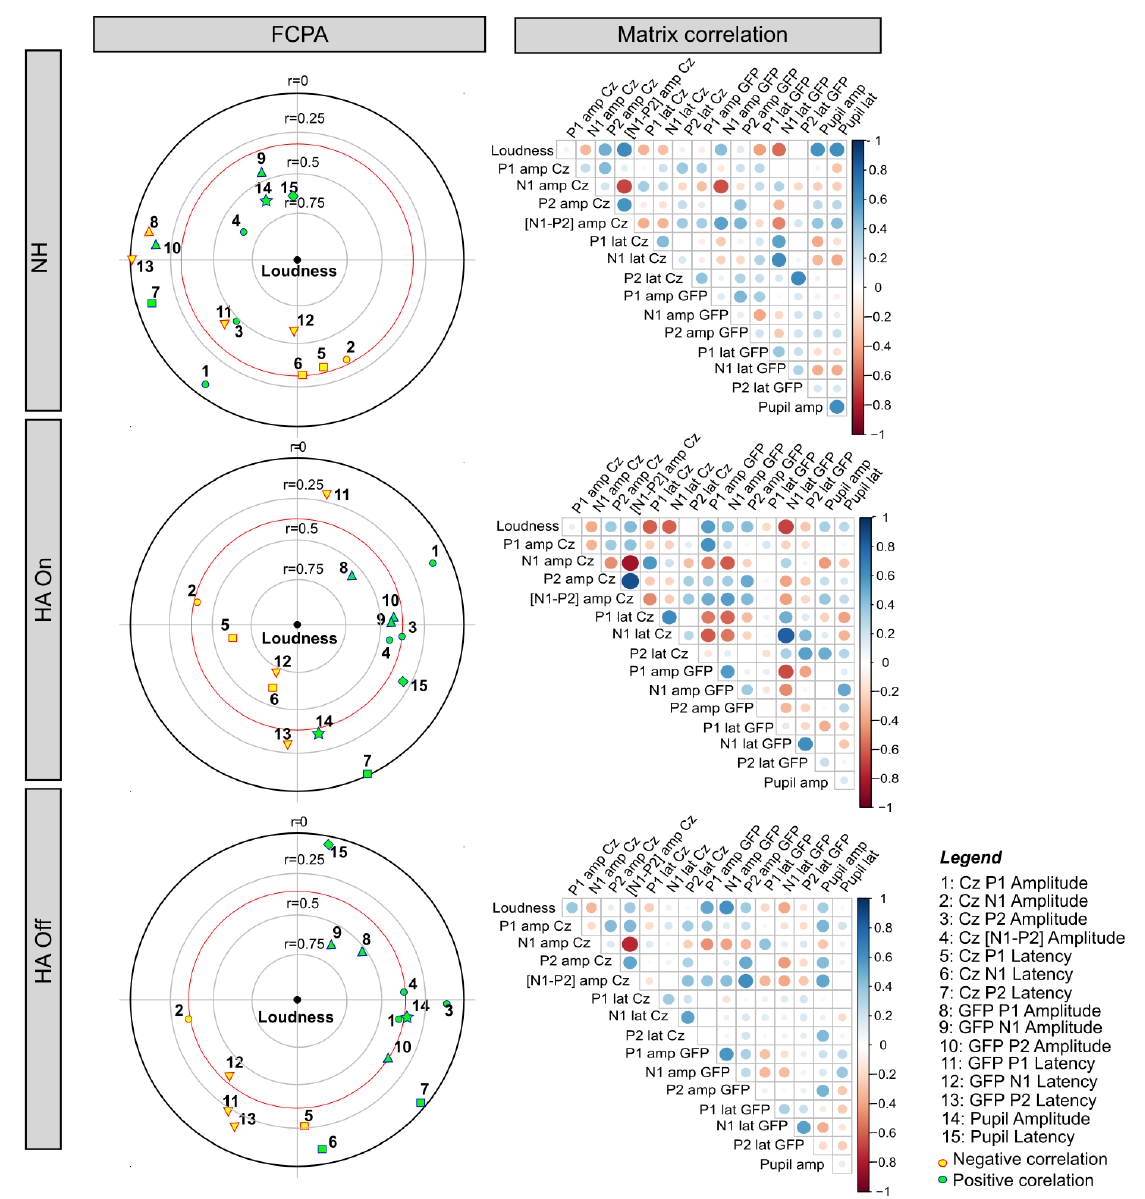
Figure 6. Left panels: FPCA plots of between loudness perception and objective responses to stimuli for the NH and HA groups (HA on or off); the center represents the variable to explain